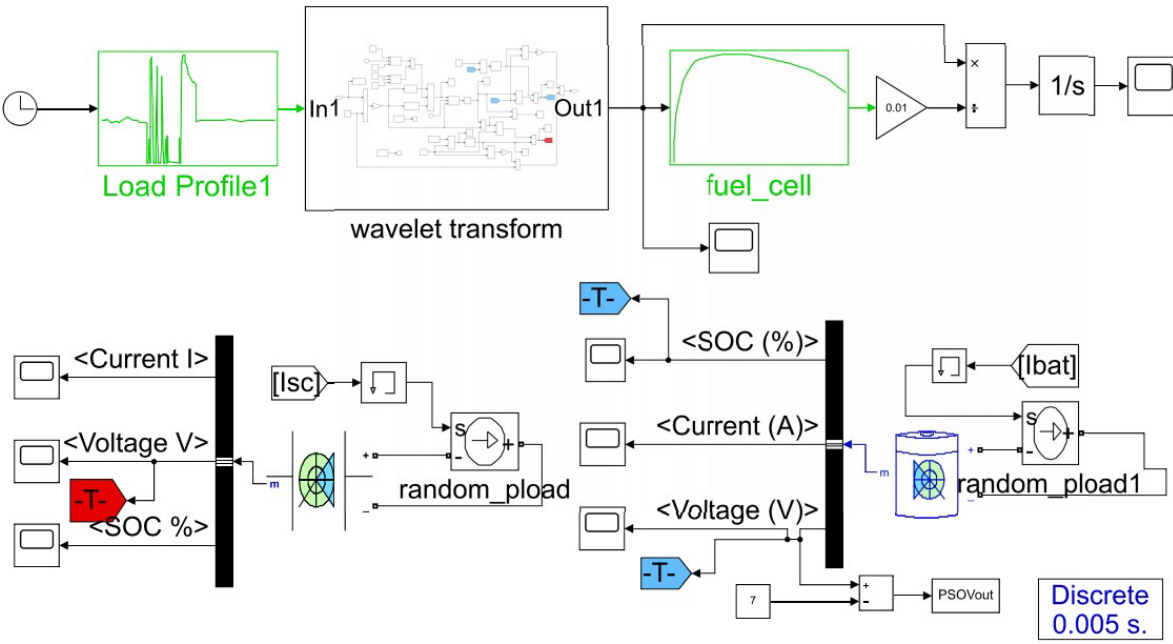
Figure 6. Simulation model of fuel cell ship hybrid power system.